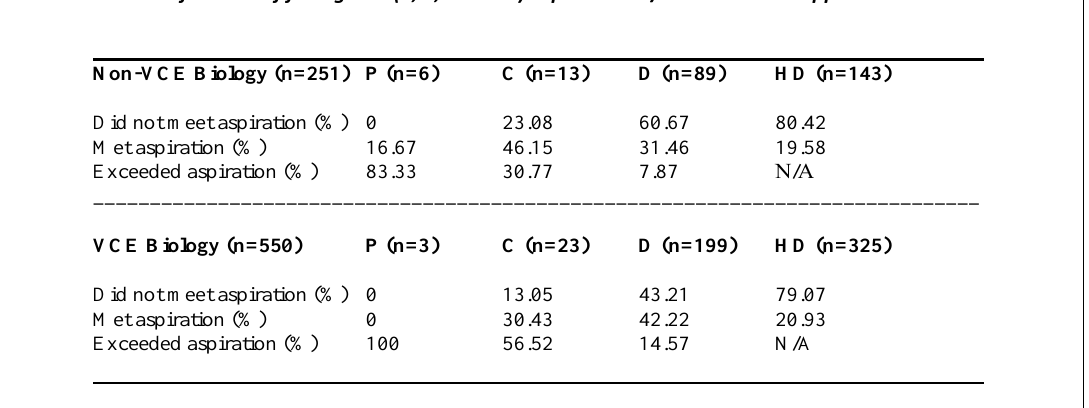
Table 1: Final grade outcomes of BIO1011 students based on prior biology and no prior biology study, as a function of final grade (P, C, D or HD) aspiration. N/A denotes Not Applicable